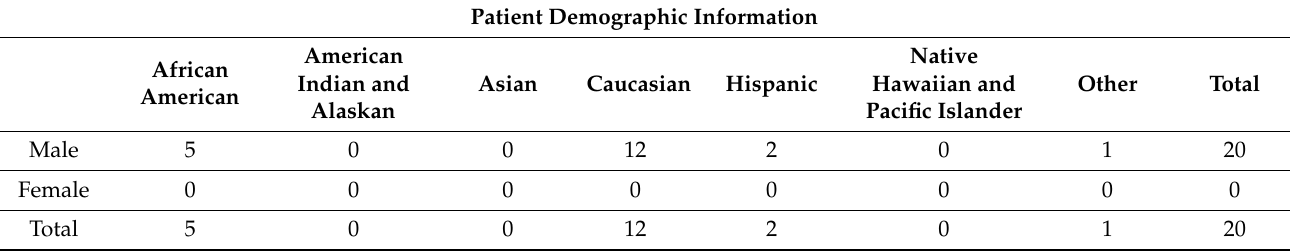
Table 4. Demographic information for 20 enrolled patients (see Table S1 for additional details). Patient Demographic